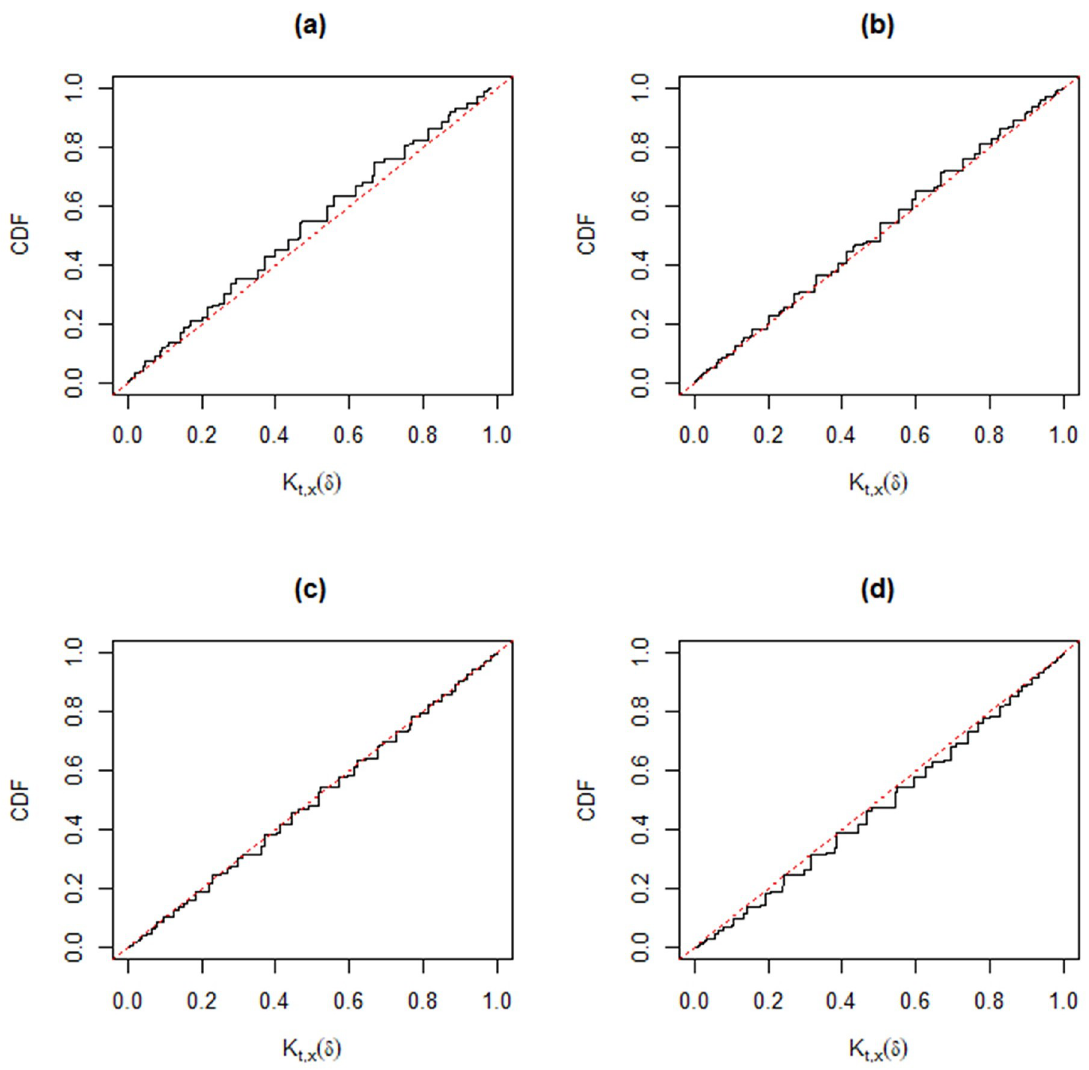
Fig 6. Distribution functions of K ( δ ) (black) compared with that of Unif(0, 1) (gray) based on Monte Carlo samples from the t , x trinomial distribution versus p 12 for fixed n = 20 and p 11 = 0.5. Panel (a): p 12 = 0.1. Panel (b): p 12 = 0.2. Panel (c): p 12 = 0.3. Panel (d): p 12 =